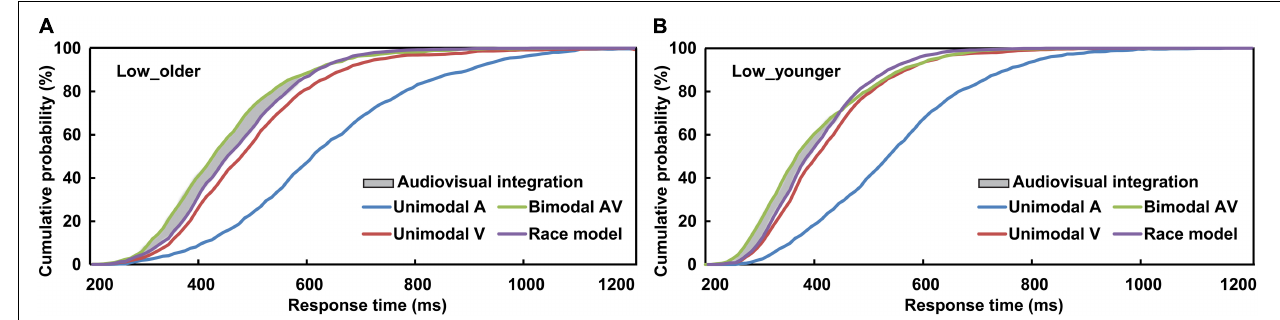
FIGURE 2 | Cumulative distribution functions of auditory stimuli, visual stimuli, race model, and audiovisual stimuli for older (A) and younger (B) adults under low visual perceptual-load conditions. Low_older, low visual perceptual-load condition for older adults; Low_younger, low visual perceptual-load condition for younger